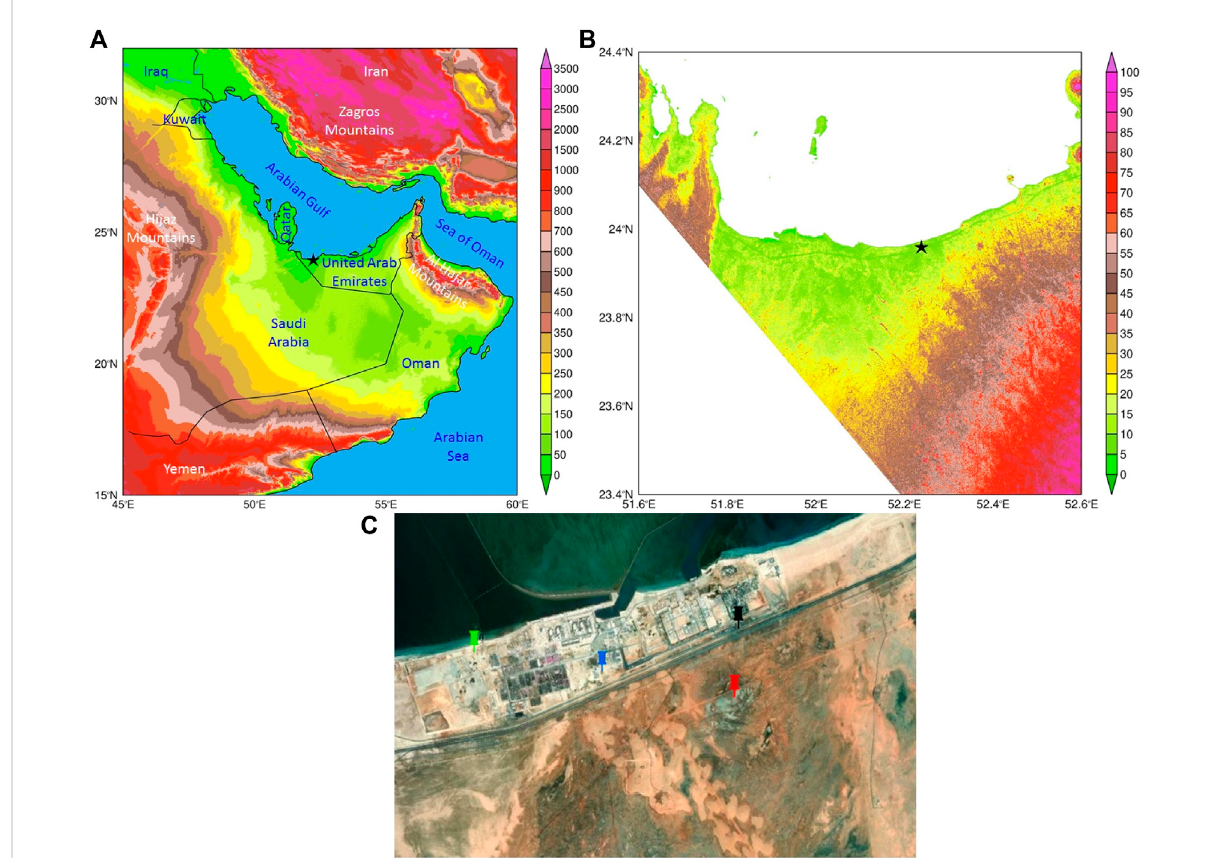
FIGURE 1 (A) Orography(m)oftheeasternArabian Peninsula at1 kmspatial resolution generated fromtheUnitedStatesGeologicalSurveydataset at30 ’’ (~927 m)resolution.ThestarindicatestheapproximatelocationoftheBarakahsite,withthelabelsindicatingthemajorfeaturesintheregion. (B) The orography of the region around Barakah from a 30-m digital elevation model (Hulley et al., 2015). (C) Close-up view of the study area. The green pin gives the location of the 10-m meteorological tower (23.96333 ° N, 52.21185 ° E); the blue pin indicates where the 60-m meteorological tower is placed (23.959849 ° N, 52.238733 ° E); the black pin is the Visitor ’ s Badging Of fi ce (VBO; 23.968052 ° N, 52.267309 ° E), where the majority of the instruments were deployed during the fi eld campaign; the red pin gives the site of the National Center for Meteorology ’ s meteorological tower (23.955277 ° N, 52.2663888 ° E) whose measurements are available for comparison with those collected at the other